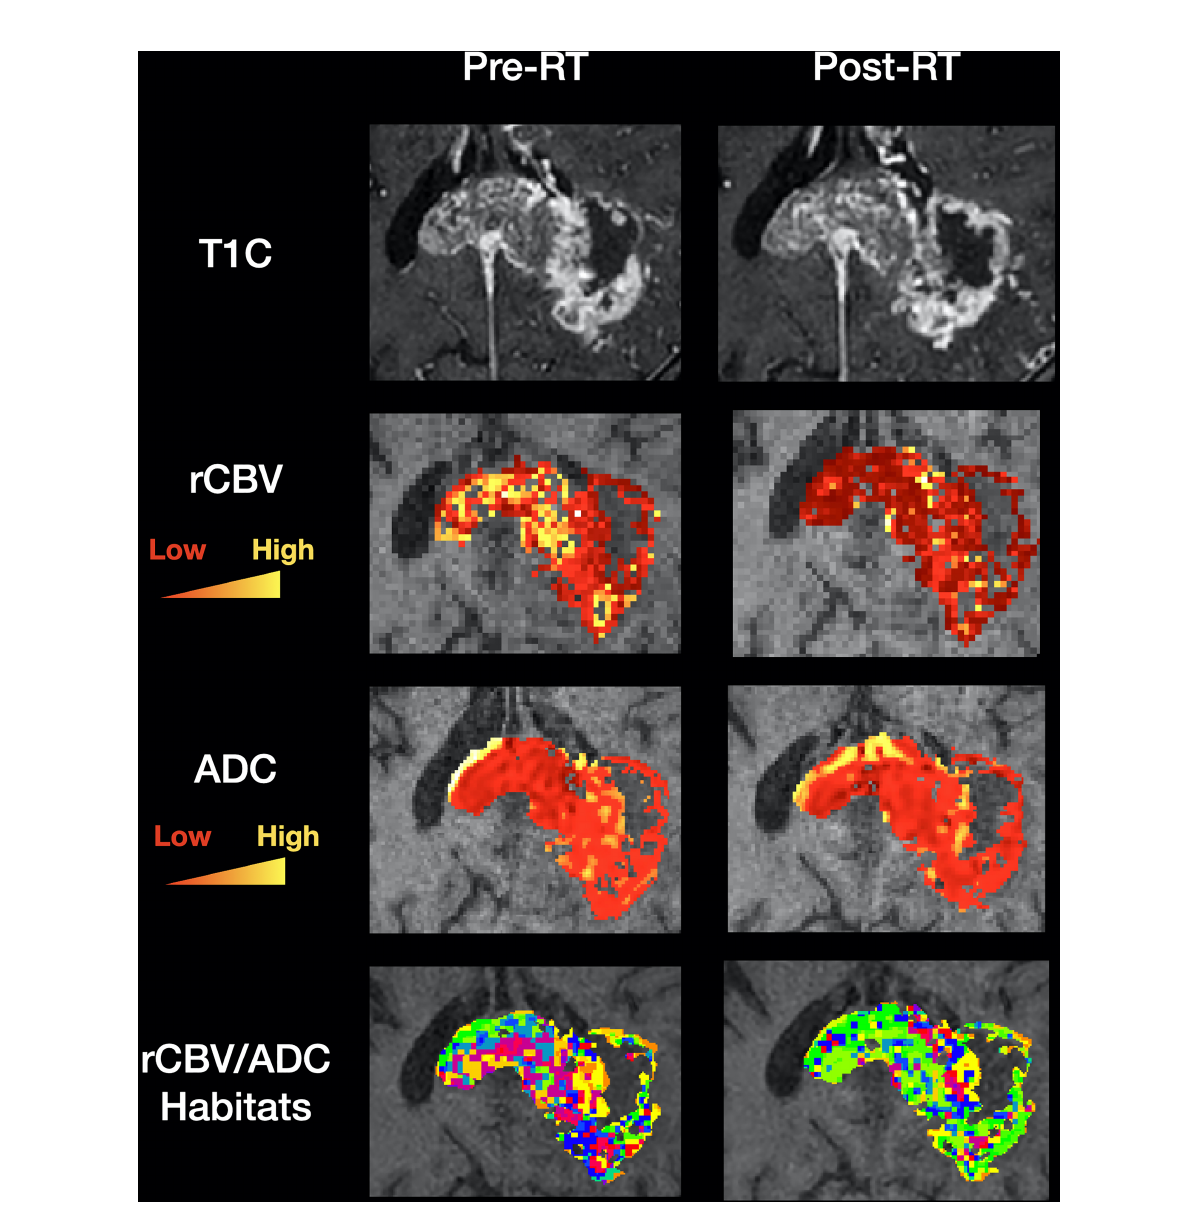
FIGURE 1 Clinical utility of habitat imaging in glioblastoma: assessment of changes pre and post-radiotherapy. This fi gure demonstrates the clinical utility of habitat imaging in glioblastoma pre and post-radiotherapy. Top row – structural imaging (T1 with contrast) demonstrates no signi fi cant changes in tumour anatomy. Middle two rows – diffusion and perfusion MRI scans demonstrate changes in tumour physiology with treatment with a decrease in rCBV for example (red to yellow represents low to high values for each biomarker). Bottom row – imaging habitats map where each voxel is labelled according to both rCBV and ADC values. This method produced 16 different habitats for this patient. After radiotherapy, the biggest increase was in a habitat de fi ned by low rCBV and low ADC (10.5% increase). The biggest decrease was in a habitat de fi ned by high rCBV and medium ADC (5.7% decrease). Habitats that are more resistant to treatment can be spatially visualised and offered targeted therapy. RT, radiotherapy; T1C, T1 with contrast; rCBV, relative cerebral blood volume normalised to contralateral white matter; ADC, apparent diffusion coef fi